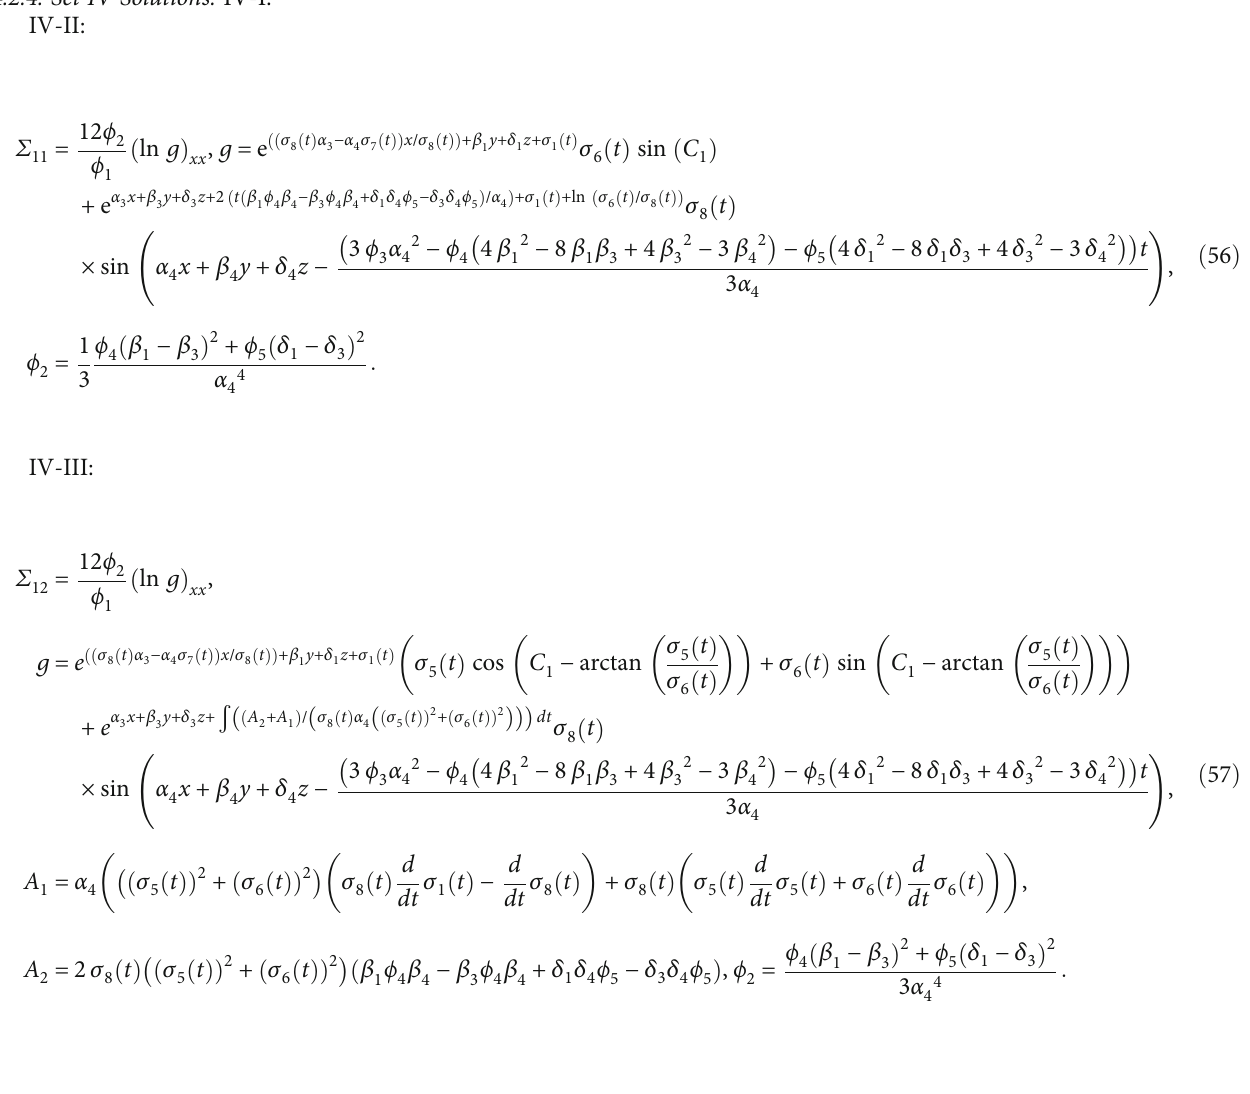
Þ (3D plot, density plot, and 2D plot t ), 10